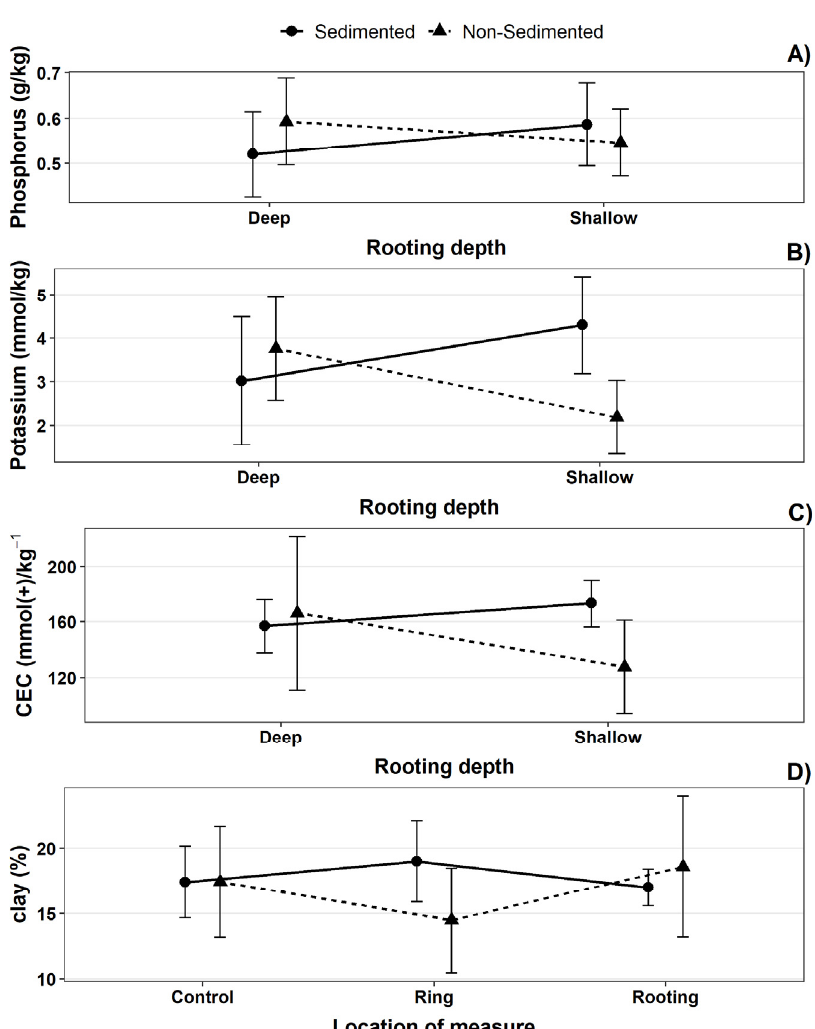
Figure 5. Plots of the significant interaction effects: rooting depth type × sedimentation in ( A ) Phos- phorus, ( B ) Potassium, ( C ) Cation Exchange Capacity levels, and sedimentation×location in ( D ) clay content.